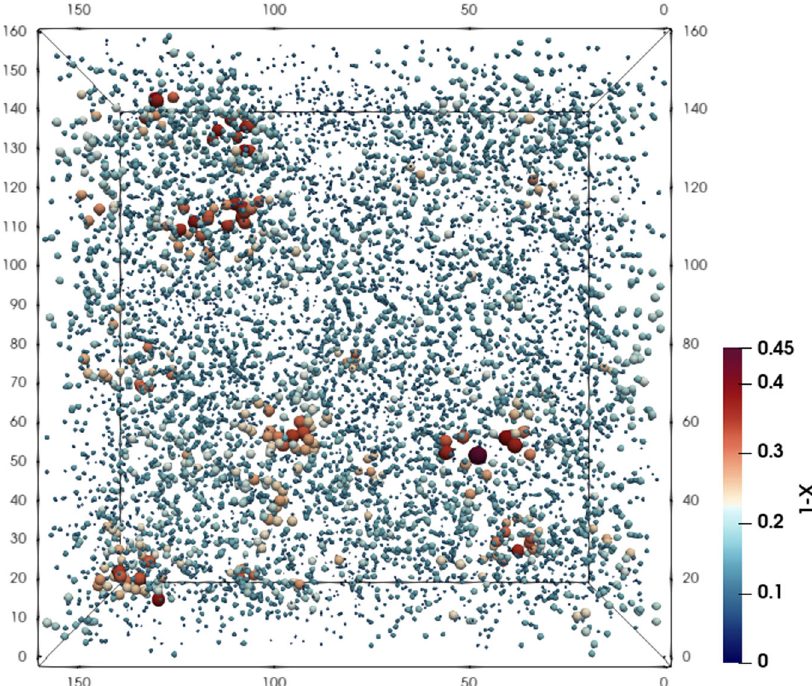
Fig. 2 Dynamic temperature chaos is spatially heterogeneous. The 8000 randomly chosen spheres in a sample of size L = 160 are depicted with a color code depending on 1 − X [ X is the chaotic parameter, Eq. (3), as computed for spheres of radius r = 12, ξ = 12 and temperatures T 1 = 0.7 and T 2 = 1.0]. For visualization purposes, spheres are represented with a radius 12(1 − X ), so that only fully chaotic spheres (i.e., X = 0) have their real